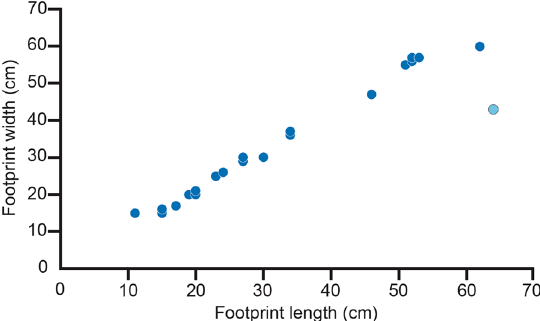
Figure 6. Graph of length and width measurements of hadrosaurid tracks from study area showing a linear relationship in size from small to large. Such a relationship indicates the presence of a multi-generational herd of these dinosaurs in this area.